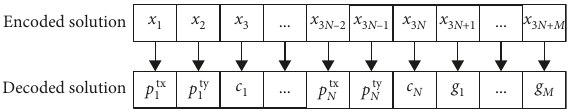
Figure 2: Traditional encoding/decoding scheme